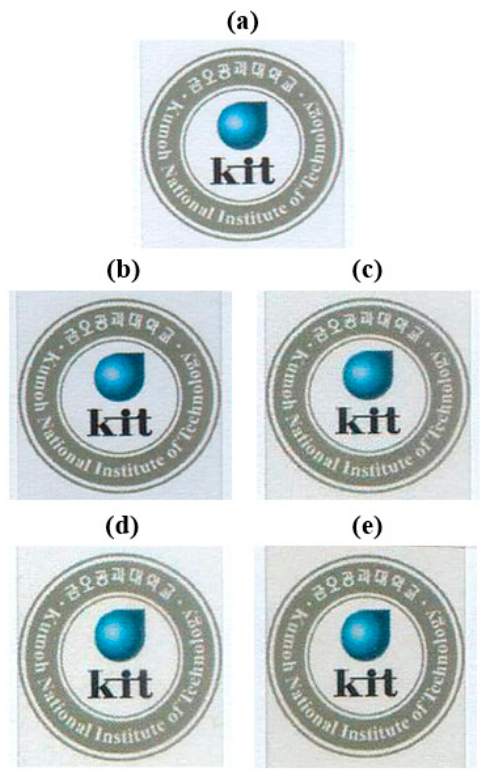
Figure 11. Photographs of PI hybrid films with BAS monomer containing. ( a ) 0 (pure PI), ( b ) 0.25, ( c ) 0.50, ( d ) 0.75, and ( e ) 1.00 wt% of Cloisite 30 B.